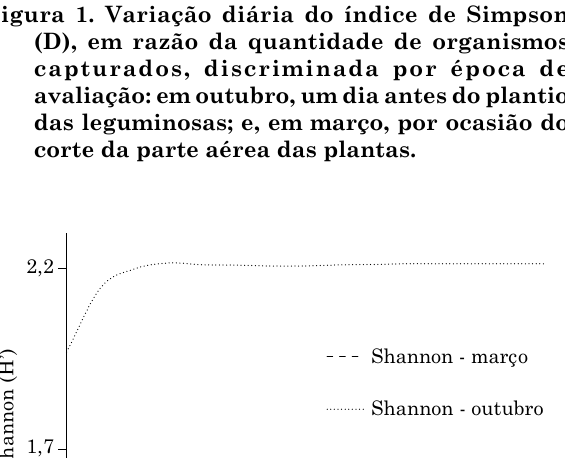
Shannon - outubro